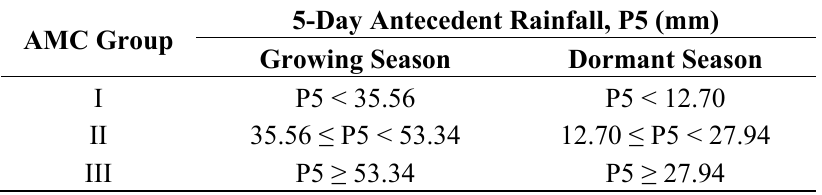
Table 5. Rainfall groups for antecedent soil moisture conditions during growing and dormant season. AMC: Antecedent moisture condition.